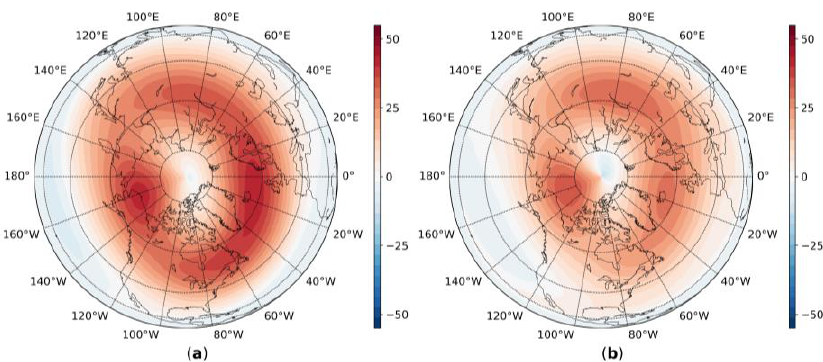
Figure 3. Long-term averaged spatial structure of the zonal wind [m/s] for the winter period (De- cember – February) at the level of 30 hPa according to the control experiment (averaging period 100 years) ( a ), according to the JRA-55 reanalysis data (averaging period [1958/59 – 2020/21]) ( b ).